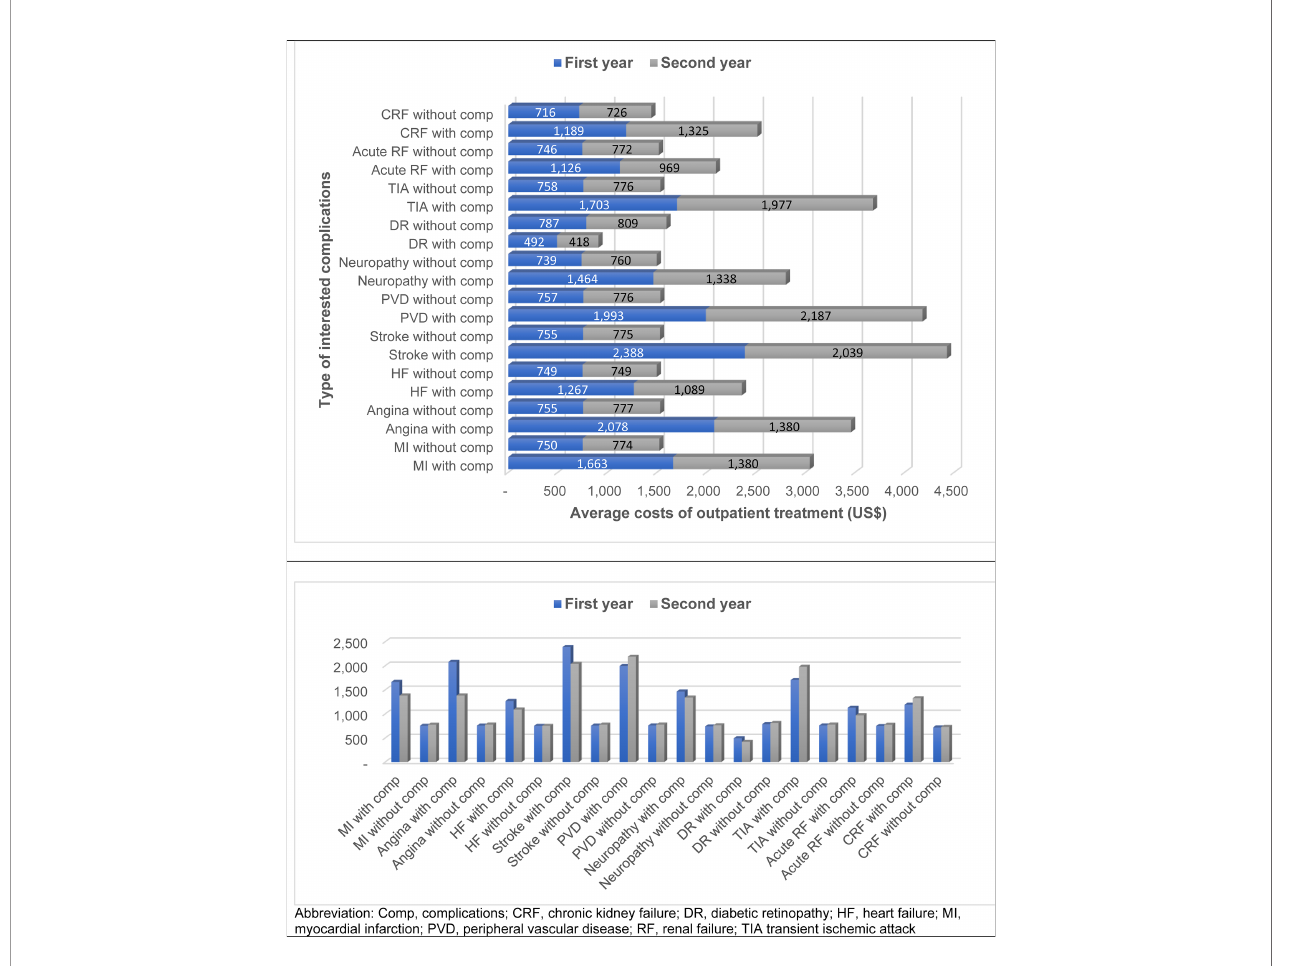
FIGURE 2 | Outpatient treatment costs for type 2 diabetes with and without interested